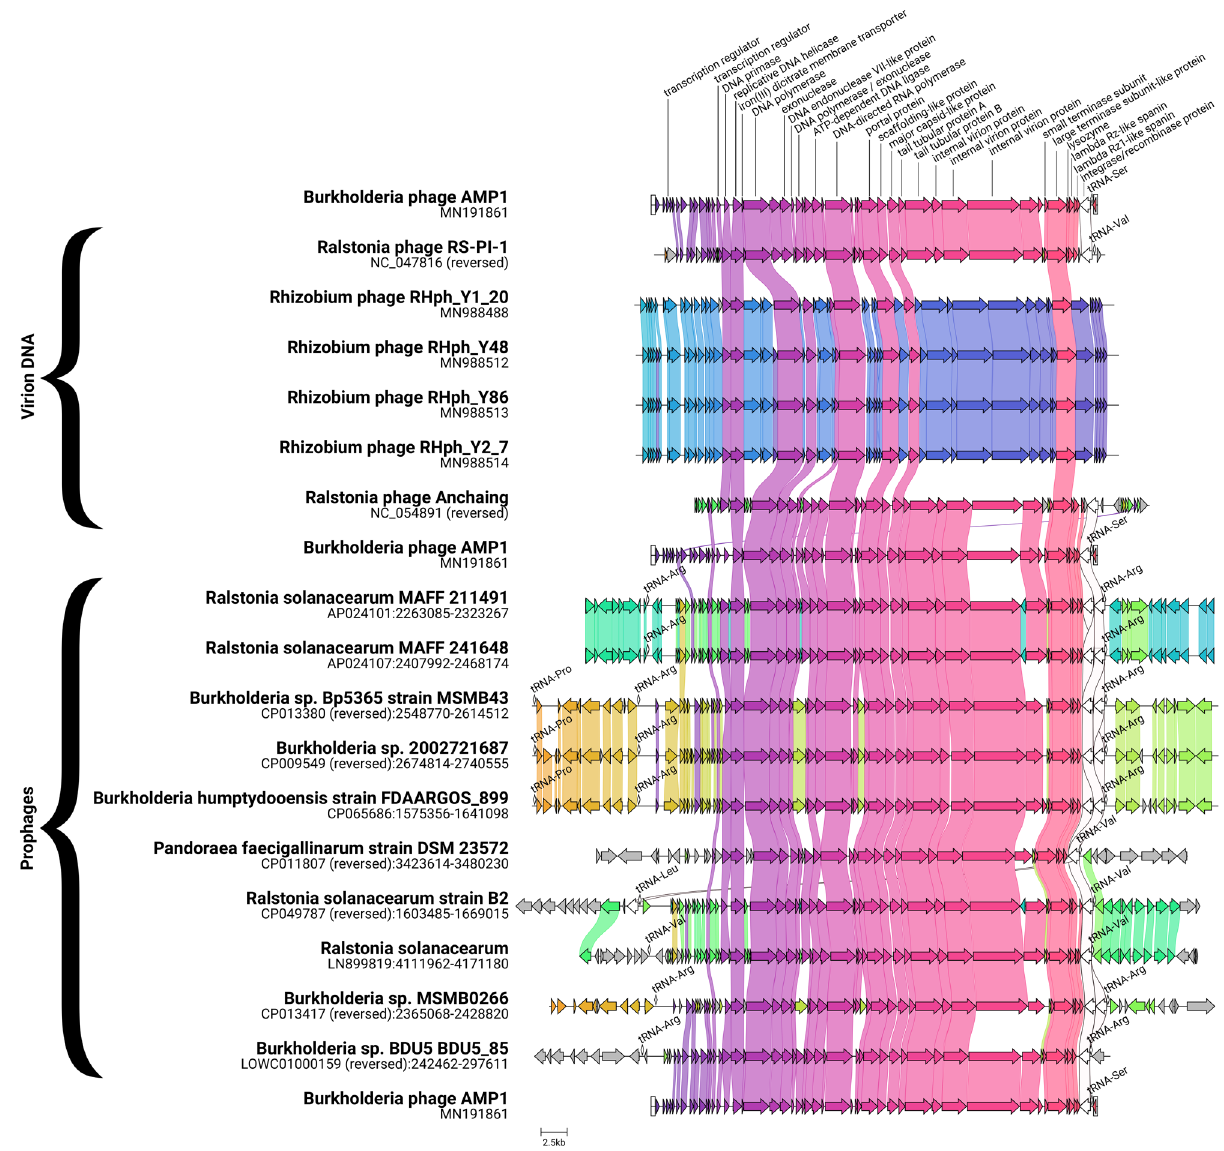
Figure 1. AMP1 related phages and putative prophages. Genes encoding proteins having more than 30% identical amino acid residues are linked. The color code for links and genes highlights sequence homology. Small diamonds indicate tRNA genes. Terminal repeats annotated in the phage genomes are